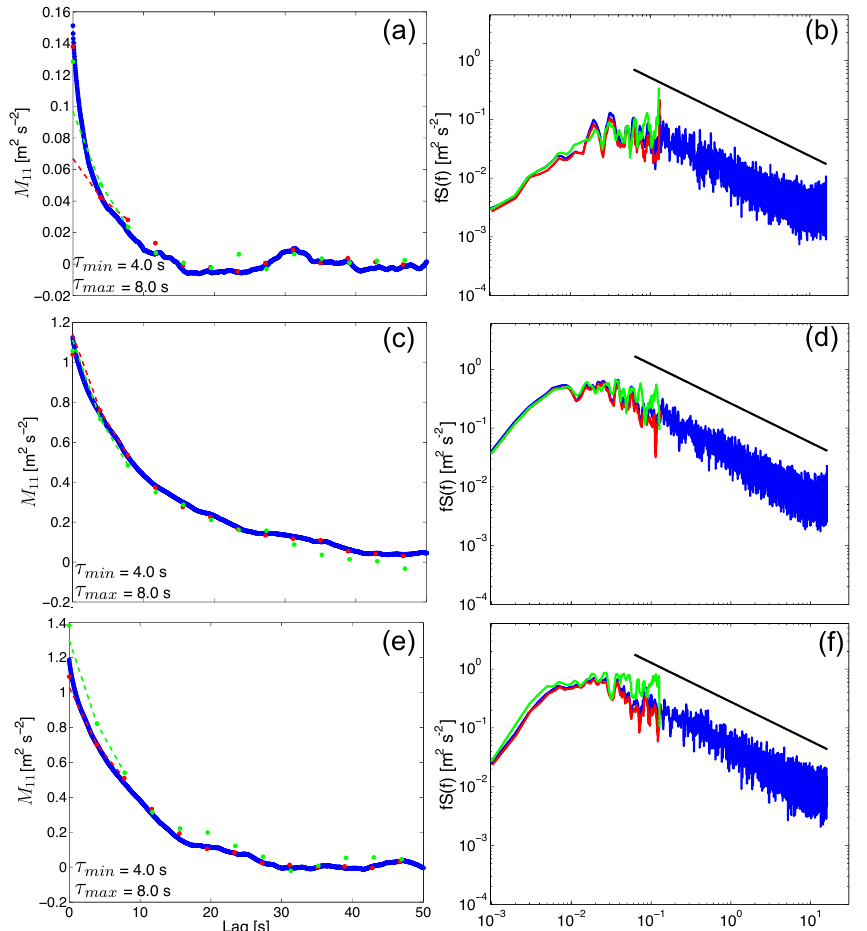
Figure 9. Sample M 11 (left column) and the corresponding spectra (right column) averaged over different 30min time periods for mea- surements at 100m. The spectra are made by averaging 10min spectra within the 30min time period to reduce the noise within the spectra. Measurements shown are those calculated from the raw sonic observations (blue), sonic data averaged to match the lidar averaging time (red), and LLNL WC observations (green). Dashed lines overlaid on M 11 are the fittings of the structure function fit to the corresponding measure- ment. The solid black line in the spectra denotes the theoretical − 2/3 slope in the inertial subrange. The fitting for the filtered sonic data uses the same lags as for the DL. M 11 and the spectra are computed over 00:30–01:00UTC (a, b) , 21:30–22:00UTC (c, d) , and 17:30–18:00UTC (e, f) on 27 March. Observations in (a, b) are during weakly stable conditions ( Ri = 0 . 1), while data shown in (c–f) are during near-neutral conditions ( | Ri | < 0 . 05). Values of τ max and τ min for each time period is shown in the lower left of (a, c, e) . Spectra are smoothed for clarity using a 5-point moving